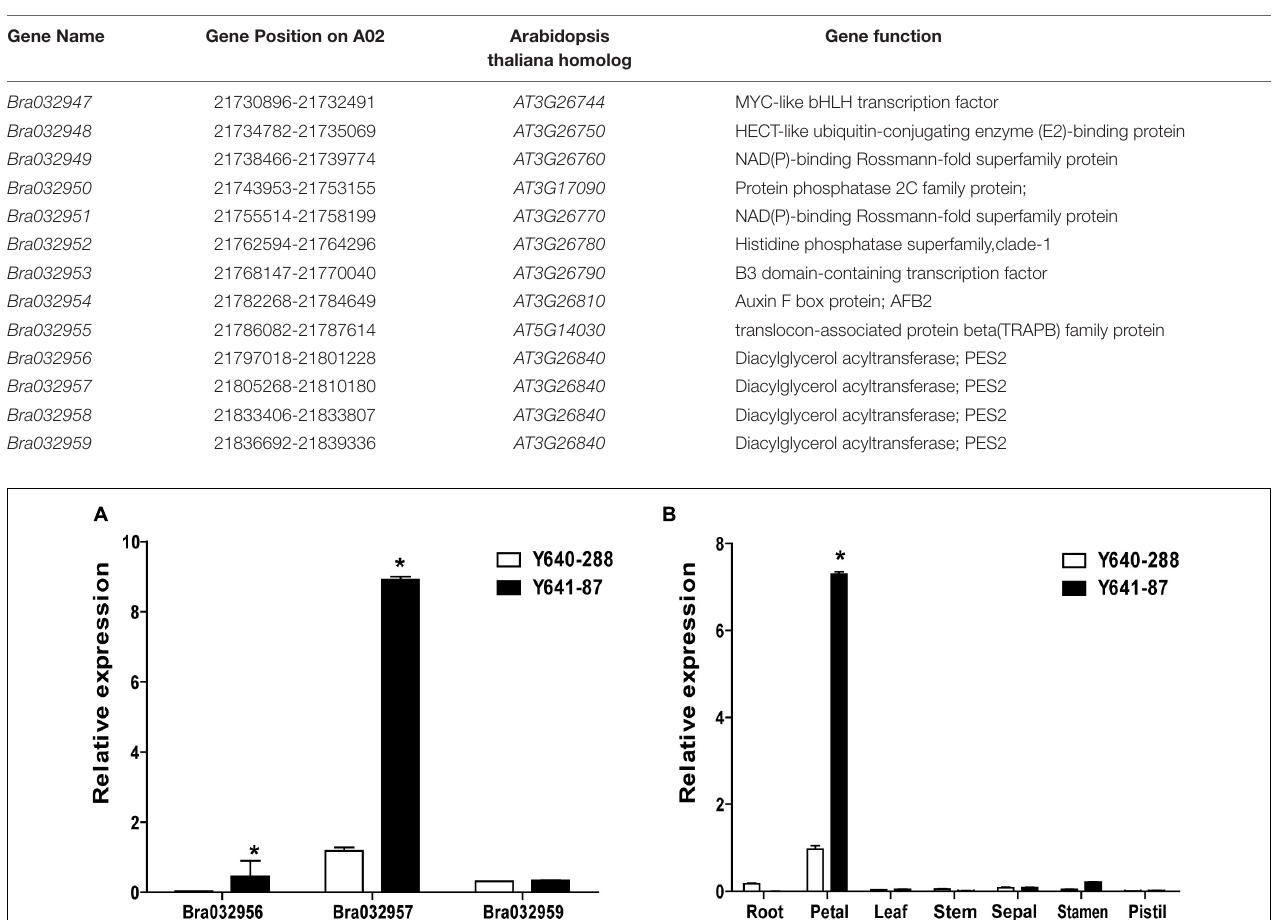
TABLE 3 | Annotated genes in the candidate interval of the BrWF3 locus.